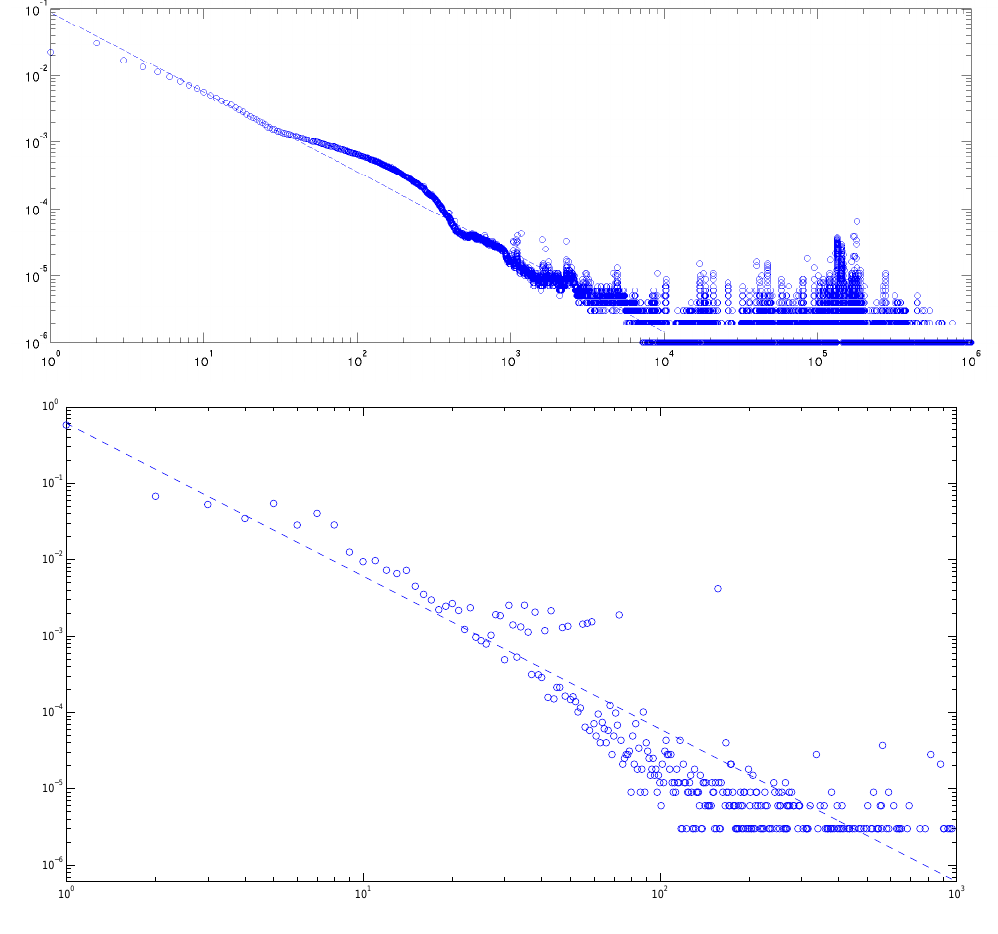
Figure 1. The distribution of gaps between neighboring nodes (top) and (bottom) of node degrees in the dataset “ in-2004 ” as gathered by Boldi and Vigna [3] using UbiCrawler